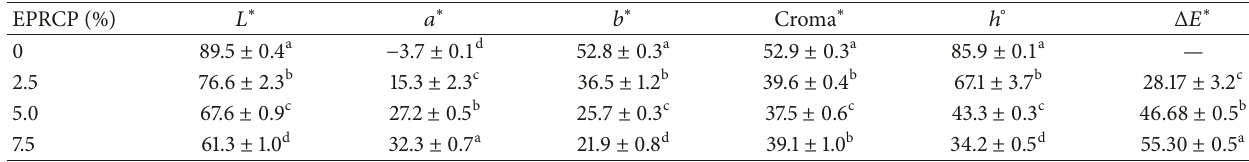
Table 3: Color parameters ∗∗ of extrudates using encapsulated powder of red cactus pear (EPRCP) as pigment. EPRCP (%) 𝐿 ∗ 𝑎 ∗ 𝑏 ∗ Croma ∗